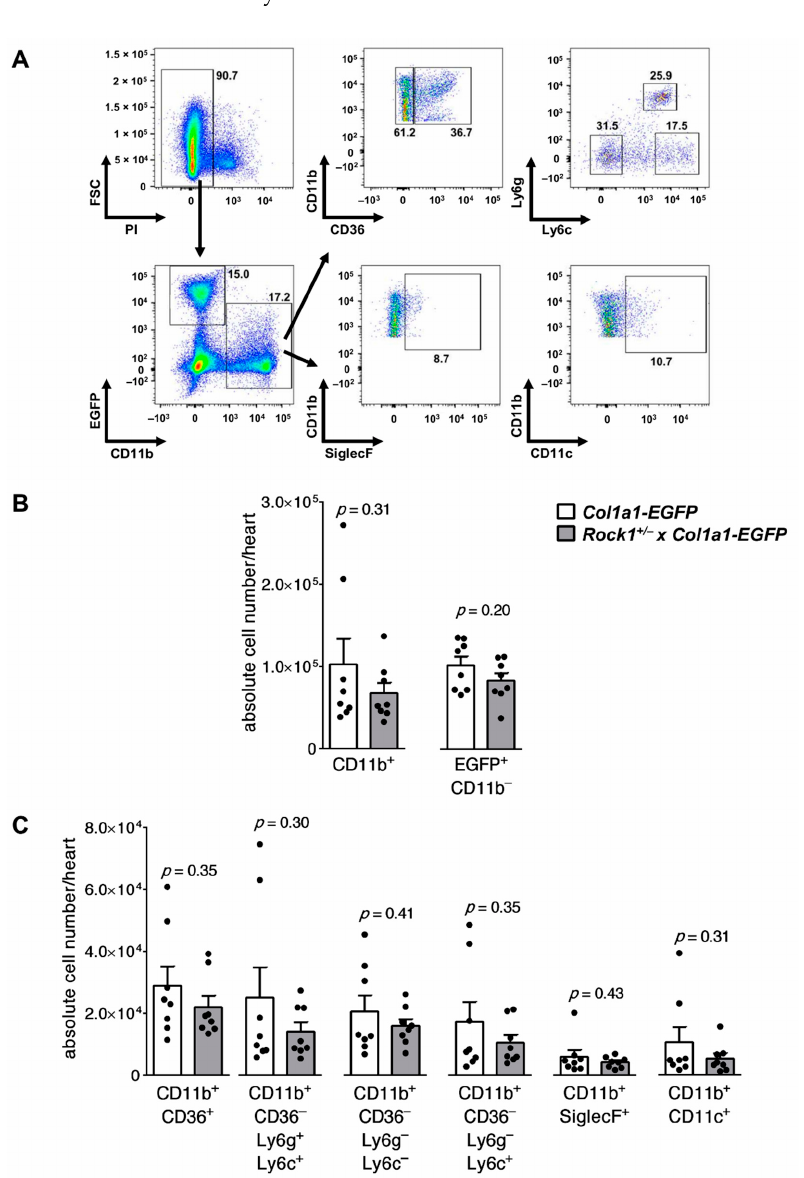
Figure 2. Flow cytometry analysis of cardiac inflammatory cells in wild-type and Rock1 +/ − mice at the acute stage of myocarditis. Panel ( A ) shows gating strategy for myeloid (CD11b + ) cell subsets and cardiac fibroblasts (EGFP + CD11b – ) in flow cytometry analysis of hearts obtained from mice with the Coll-EGFP reporter transgene. Analysis of unstained heart sample is shown in Supplementary Figure S2. Quantifications of total number of myeloid and cardiac fibroblasts, as well as indicated myeloid cell subsets in hearts of Coll-EGFP (n = 8) and Rock1 +/ − x Coll-EGFP (n = 8) mice, at day 21 of EAM are shown in panels ( B ) and ( C ), respectively. Each dot represents data for one heart, and bars present mean value ± SEM. p -value was calculated with the unpaired Student’s t -test.